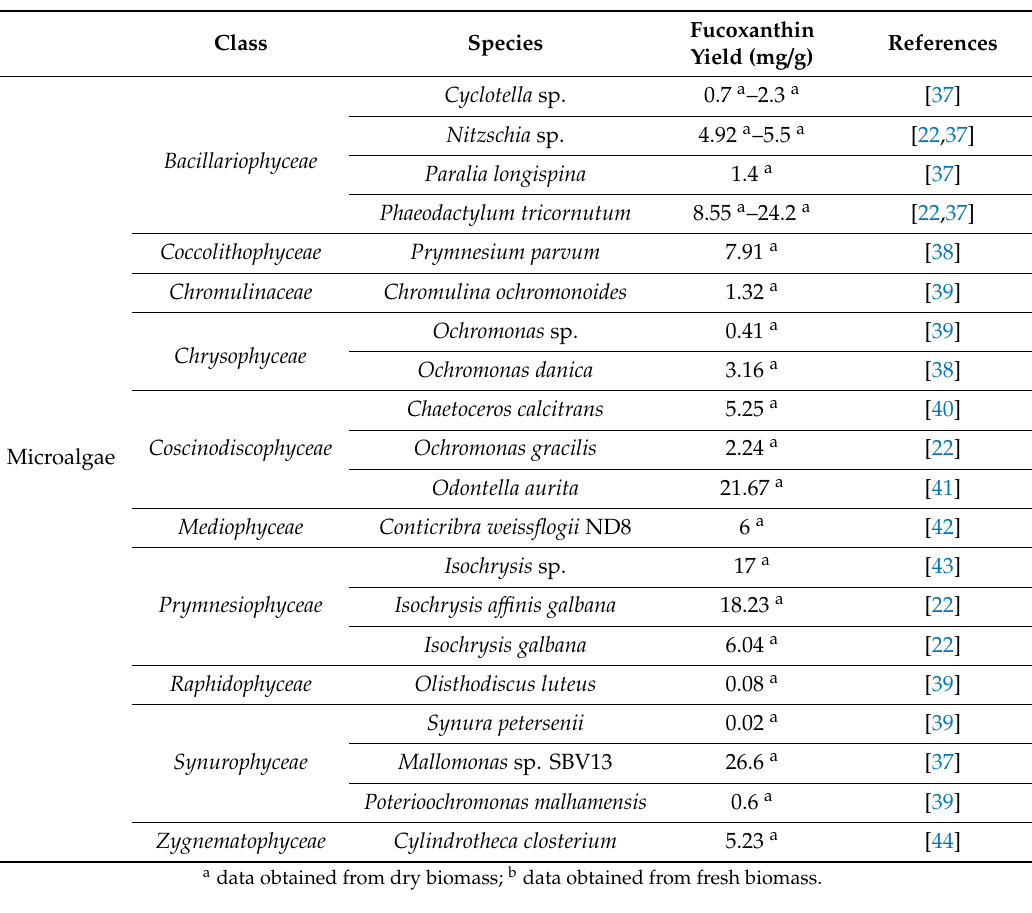
Table 1. Source and concentration of fucoxanthin in different algal samples.